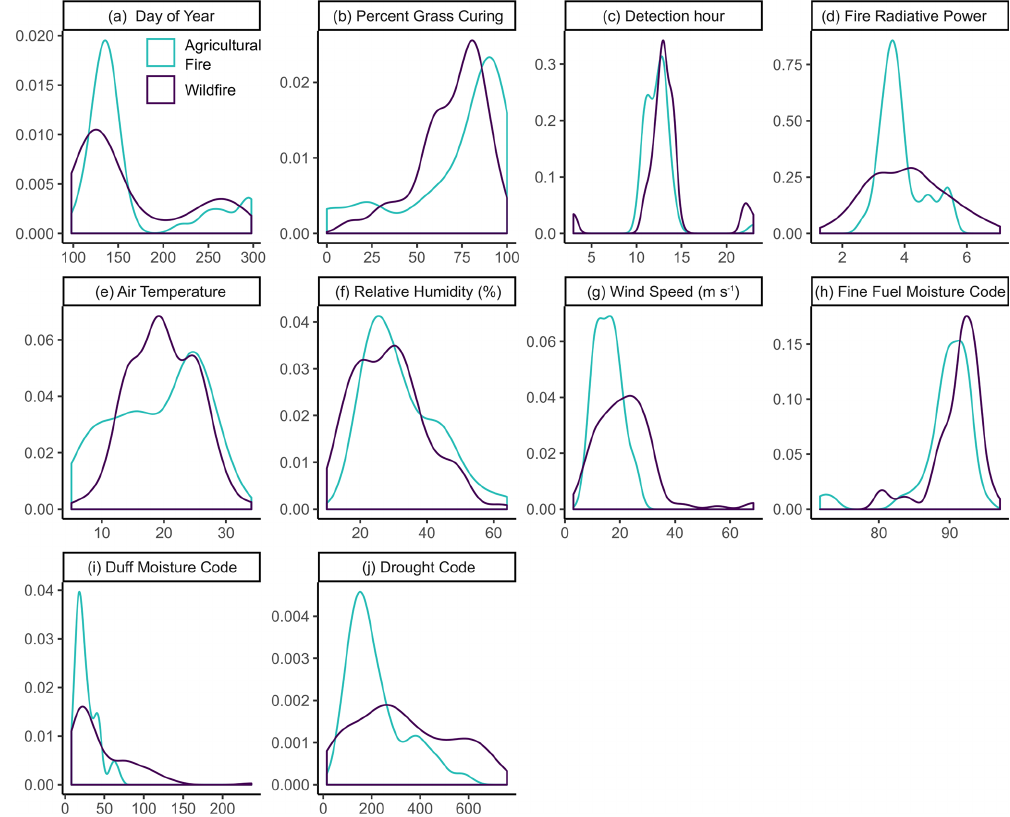
Figure 4. Distribution of hotspot cluster properties between wildfires (purple) and agricultural fires (blue). Fire radiative power is given in megawatts and transformed by the natural logarithm.